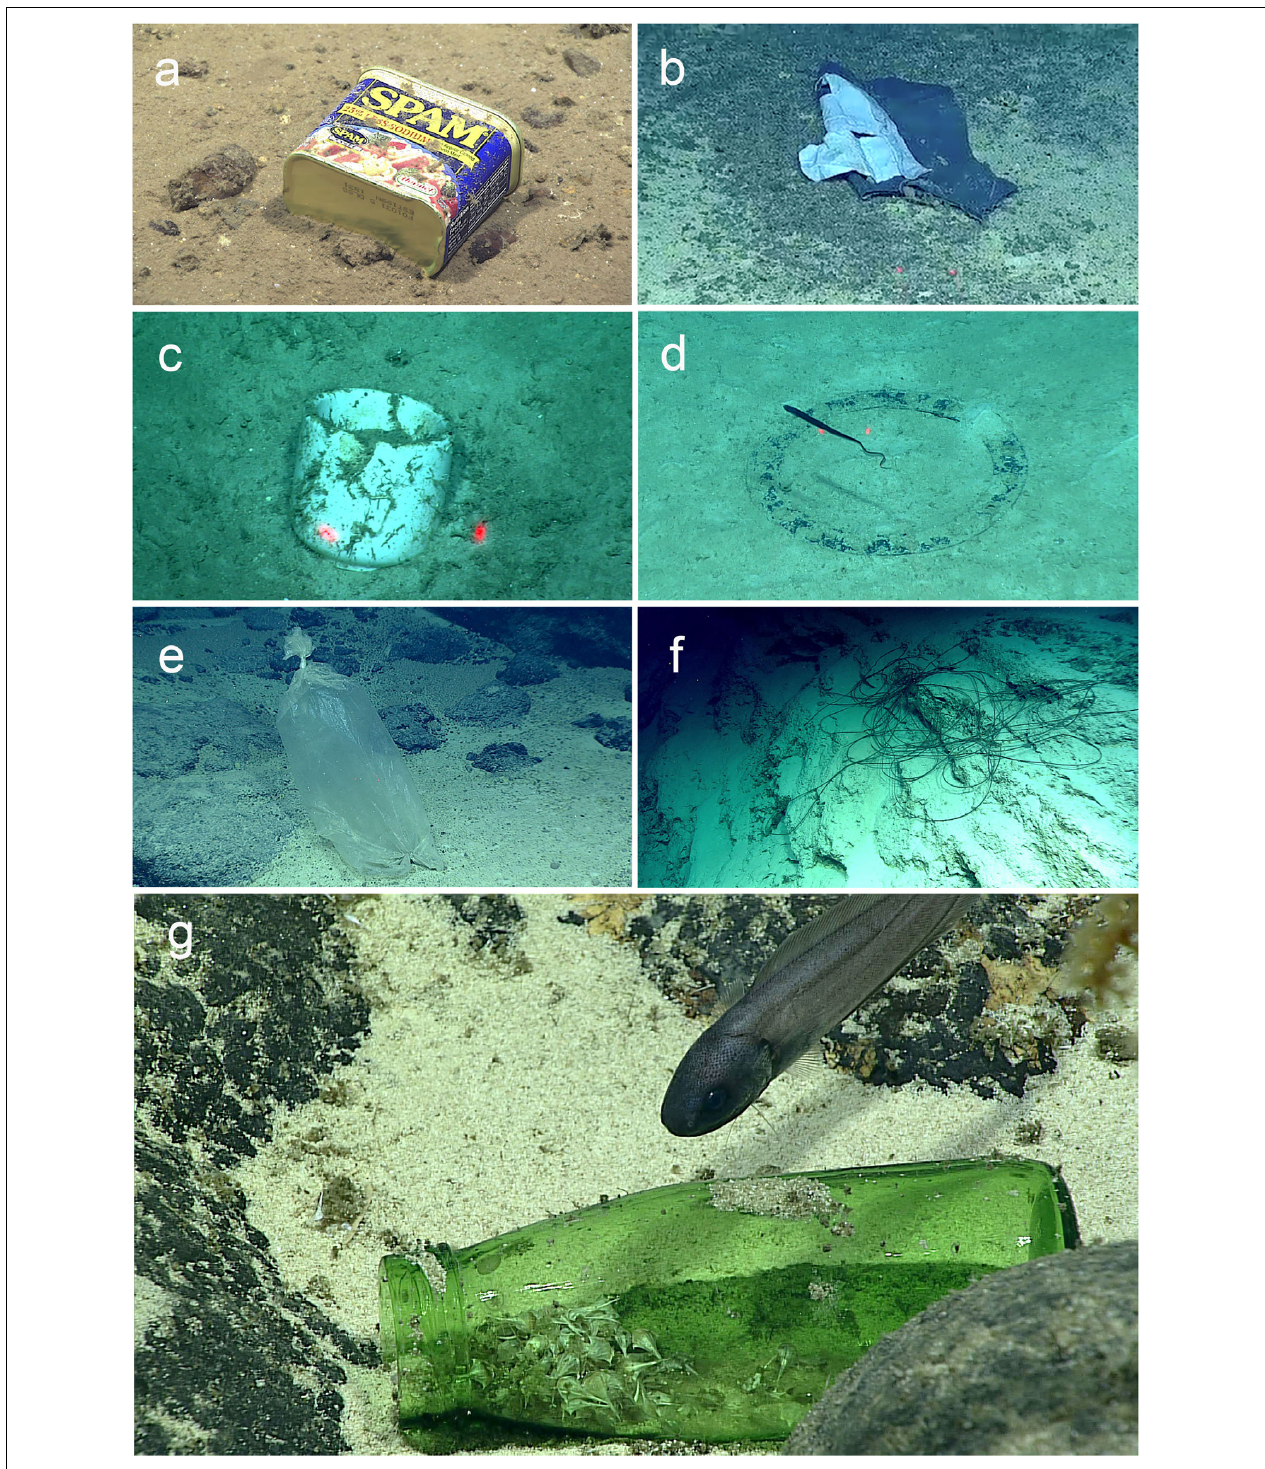
FIGURE 4 | Types of deep-sea debris observed. (a) Metal debris – a food tin at 4,947 m in Sirena Canyon off the Mariana Islands. (b) Cloth debris – a piece of canvas at 3,780 m on Enigma Seamount off the Mariana Islands. (c) Other debris – a ceramic cup at 838 m at CAIMAN/I-203 off the main Hawaiian Islands. (d) Rubber debris – a gasket at 839 m at CAIMAN/I-203 off the main Hawaiian Islands. (e) Plastic debris – a plastic bag at 3,767 m on Enigma Seamount off the Mariana Islands. (f) Fishing debris – fishing line at 453 m on South Palmyra Slope in PRIMNM Kingman Reef and Palmyra Atoll. (g) Glass debris – a glass bottle at 1,152 m at Titov 2 in PRIMNM Howland and Baker Unit. The central red lasers points indicate 10 cm scale in 4b, 4c, 4d, and 4e.